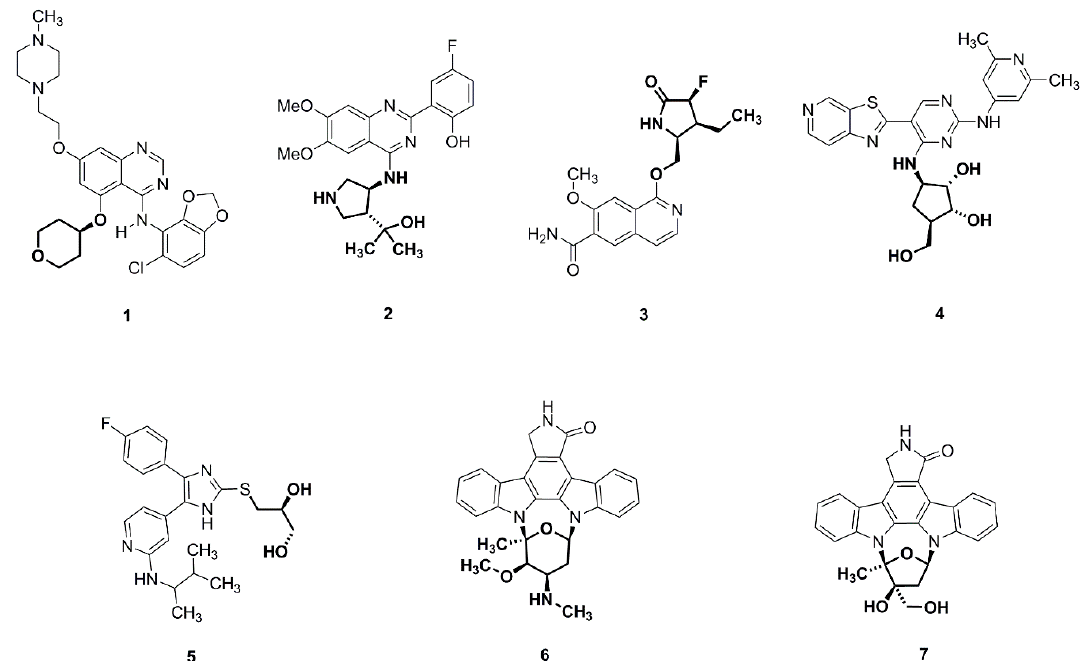
Figure 2. Selected kinase inhibitors targeting the ribose pocket or phosphate binding region with chiral hydrophilic moieties. 1 : IC 50 (c-Src) = 2.7 nM [11]; 2 : IC 50 (CHK2) = 3 nM [12]; 3 : IC 50 (IRAK4) = 0.2 nM [18]; 4 : IC 50 (IRAK4) = 0.3 nM [17]; 5 : IC 50 (p38 α ) = 15 nM [16]; staurosporine ( 6 ): Non-selective kinase inhibitor; 7 : IC 50 (Trk) = 25 nM, IC 50 (FLT3) = 2–3 nM, IC 50 (JAK2) = 0.9 nM [19].